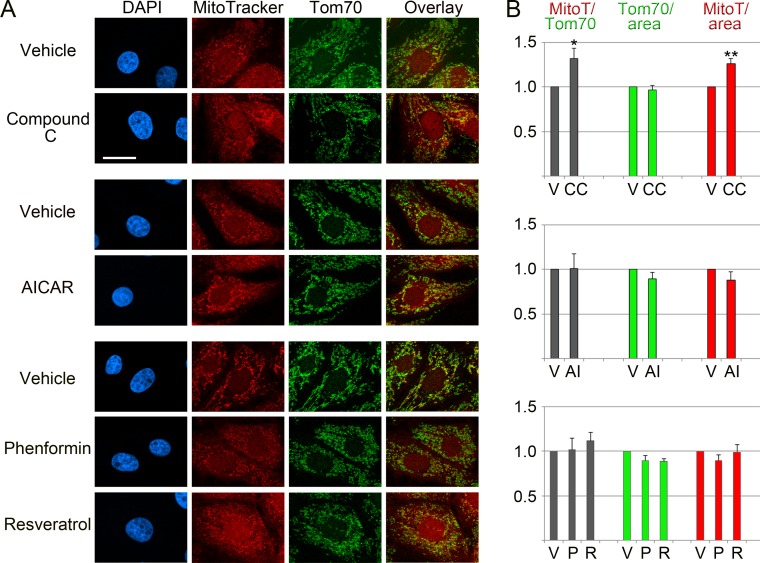
Effects of pharmacological AMPK modulators on mitochondria.LLC-PK1 cells were incubated with vehicle, compound C, AICAR, phenformin or resveratrol. (A) MitoTracker staining and the detection of Tom70 were carried out as described in ‘Materials & Methods’. DAPI staining visualized the nuclei. Scale bar is 20 µm. (B) Quantification of fluorescence signals. Results are shown for three to four independent experiments; at least 35 cells were analyzed for each data point and experiment. Data were normalized to vehicle controls. Y-axes display arbitrary units for MitoTracker/Tom70, Tom70/mitochondrial area, MitoTracker/mitochondrial area; bars depict averages +SEM. V, vehicle; CC, compound C, AI, AICAR; P, phenformin; R, resveratrol. Student’s t-test was performed to compare compound C to the vehicle DMSO, or AICAR to the vehicle water. One-way ANOVA combined with Bonferroni post-hoc analysis identified significant differences between the vehicle DMSO and samples treated with phenformin or resveratrol; *, p < 0.05; **, p < 0.01.